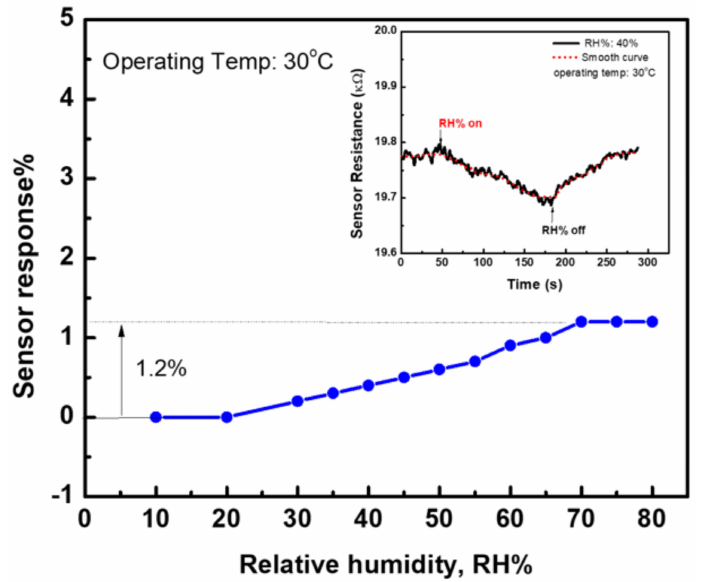
Figure 11. The sensor response at an operating temperature of 30 ◦ C for various humidity conditions for the sensor fabricated with CNTs/24 nm-Ni